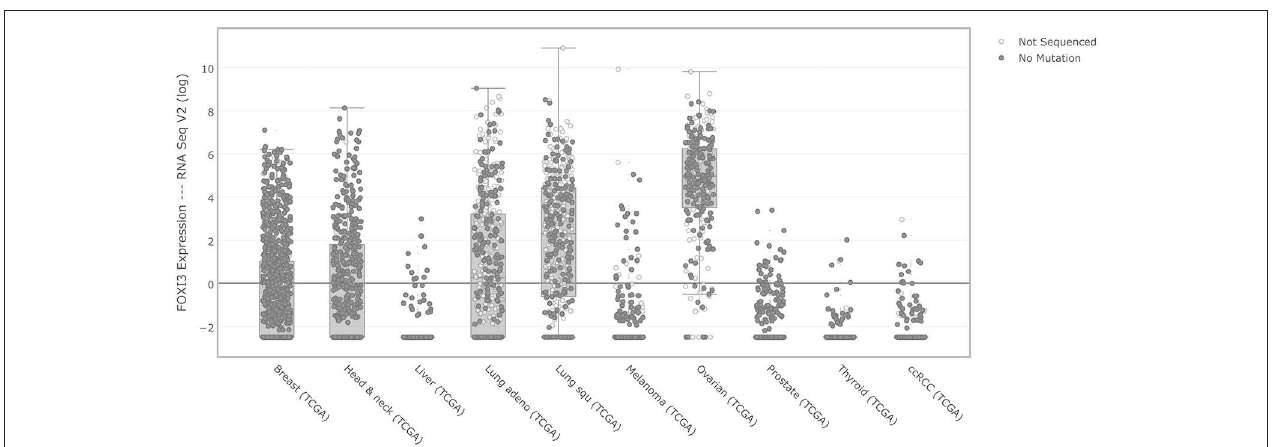
FIGURE 2 | FOXI3 expression across foremost cancer types. RSEM normalized gene expression levels of FOXI3 as shown by cBioPortal (http://cbioportal.org) across TCGA cohorts.